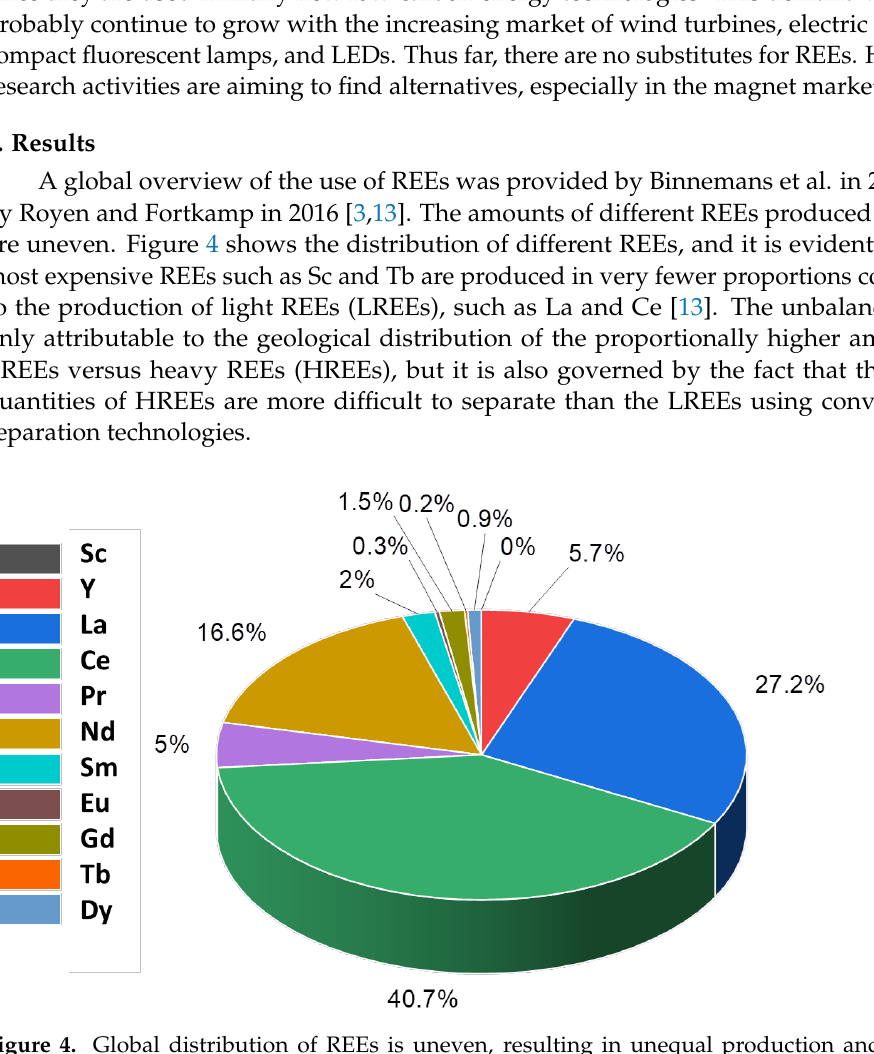
Figure 3. Leading global producers of REEs in 2020 [12].